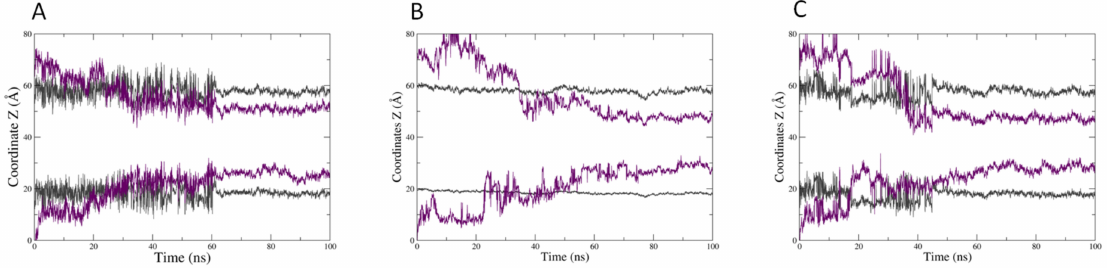
Figure 6. Transversal cut of the lipid bilayer in the presence of ( A ) 13 molecules of CIN ( B ) 13 molecules of CitA and ( C ) 13 CitO molecules. Dark grey: mean z coordinates of the mass centre of the phosphate atoms of PLPC molecules, purple: mean z coordinates of the mass centre of the herbicidal